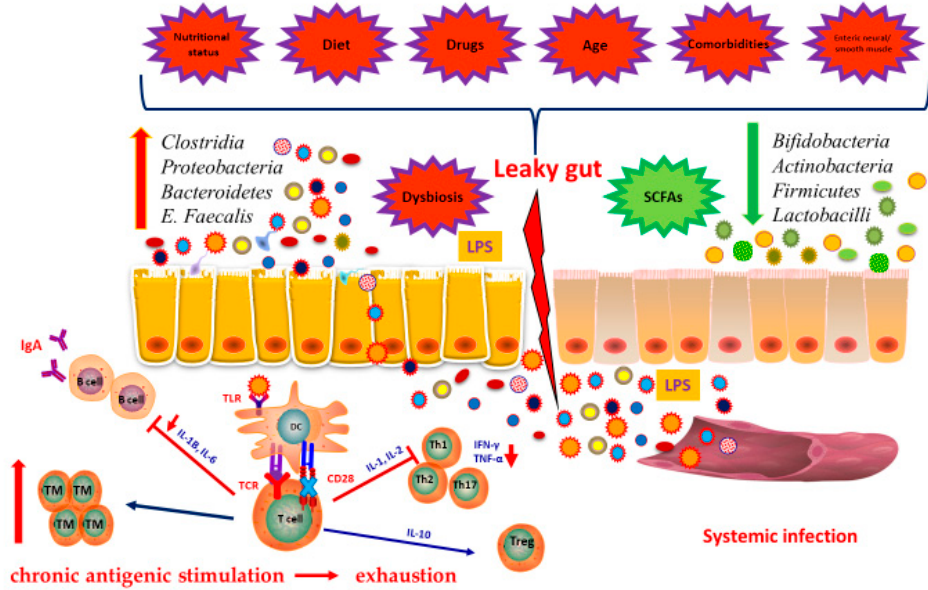
Figure 2. Interplay between microbiota and immunity in elderly. Changes in gut microbiota occur in the elderly. A condition known as “leaky gut” is associated to many diseases and common in the elderly. It is determined by alteration in several factors as diet, nutritional status, use of antibiotics or other drugs, the presence of comorbidities and the dysbiosis. Furthermore, due to leaky gut, gut microbiota can pass the gut barrier and enter the blood stream, a key step in the process of inflammaging. Furthermore, the continuous chronic antigenic stimulation causes the increased number of memory T cells. A consequence of chronic stimulation is exhaustion. Abbreviations: TM, memory T cells; DC, dendritic cells; LPS, lipopolysaccharide.